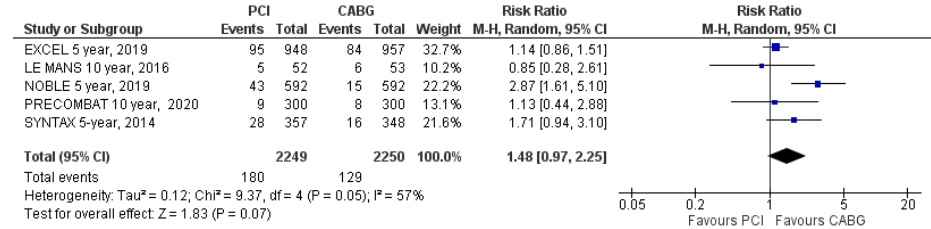
Figure 6. Risk of myocardial infarction at the latest follow-up: PCI vs. CABG.